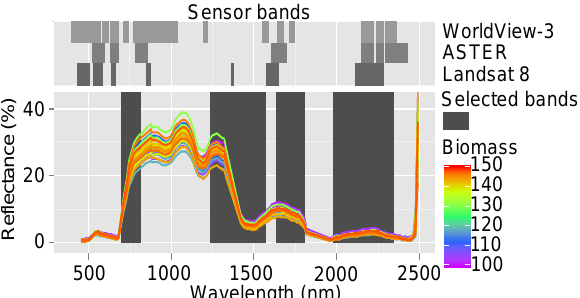
Figure 8. Coefficient values of selected band by (a) lasso and (b) fused lasso